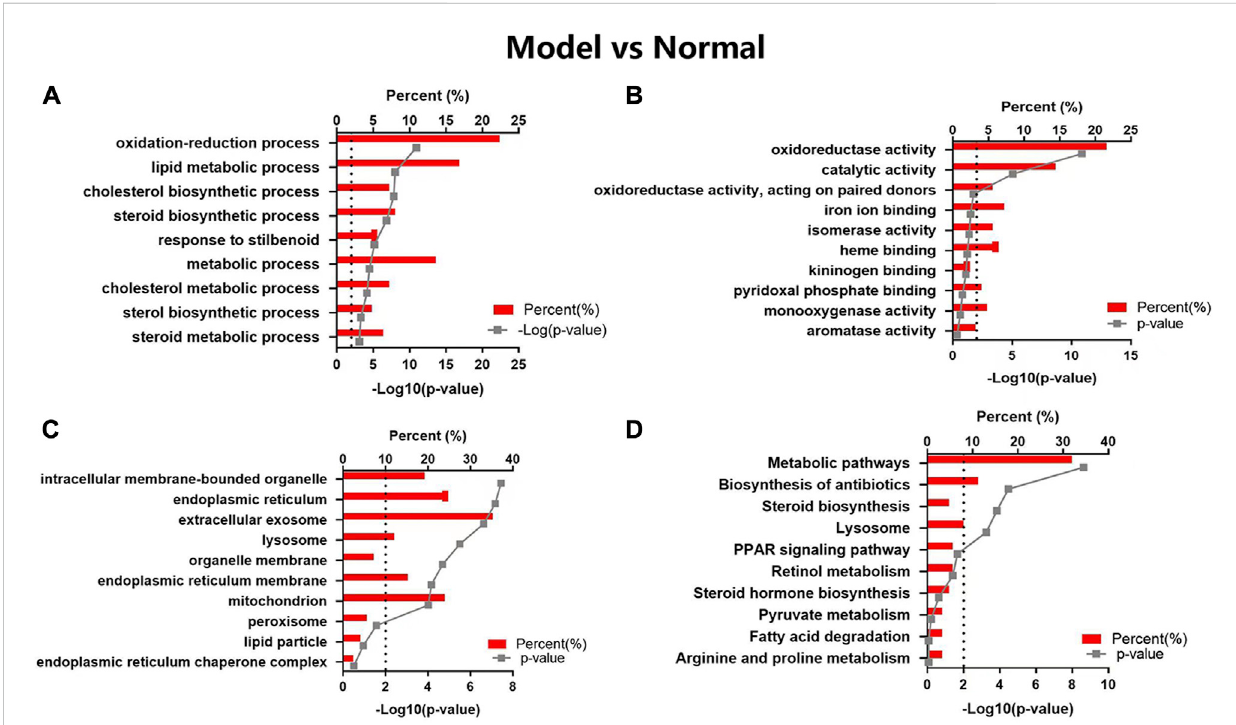
GOandKEGGpathwayanalysesofthechangedproteinsinModelvsNormalgroups.Theenricheditemsarelistedaccordingtothe p -value. (A) GO-BP, (B) GO-MF, (C) GO-CC, (D) KEGG pathway